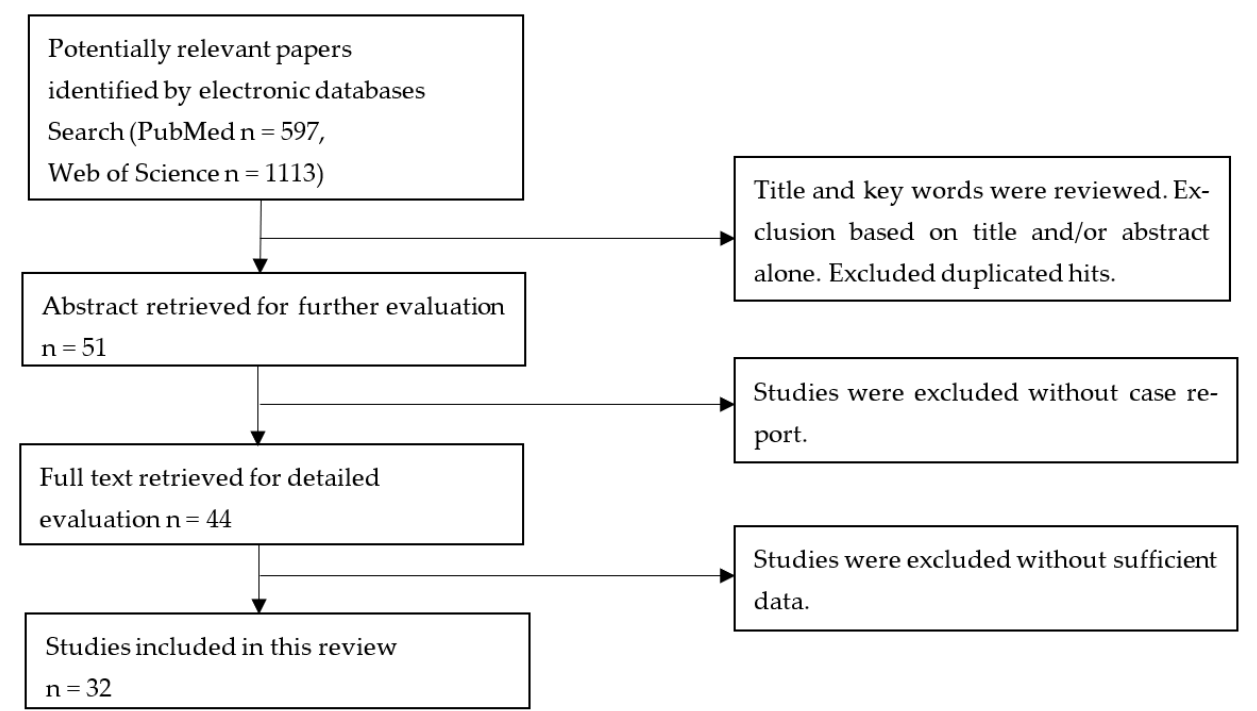
Figure 1. Flowchart of the study selection process.